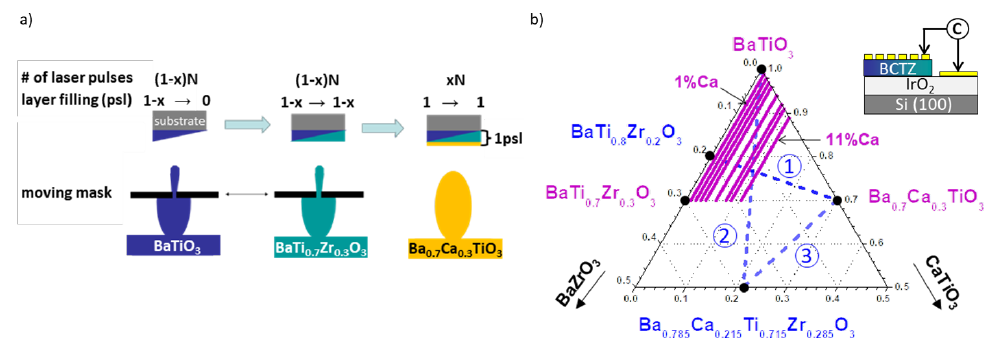
Figure 1. ( a ) Schematic of the perovskite single layer (psl) CPLD cycle deposition using 3 targets. A unique deposition rate of N laser pulses/psl is assumed and 0 < x < 1. ( b ) Targets’ composition (black dots) and synthesized libraries (purple lines from 3 targets, blue dashed lines from 2 targets) represented within the BaTiO 3 -BaZrO 3 -CaTiO 3 ternary phase diagram. Inset represents a schematic of the sample’s microstructure.